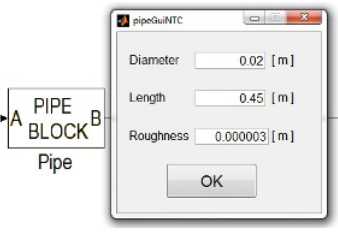
Fig. 4. Element set-up.